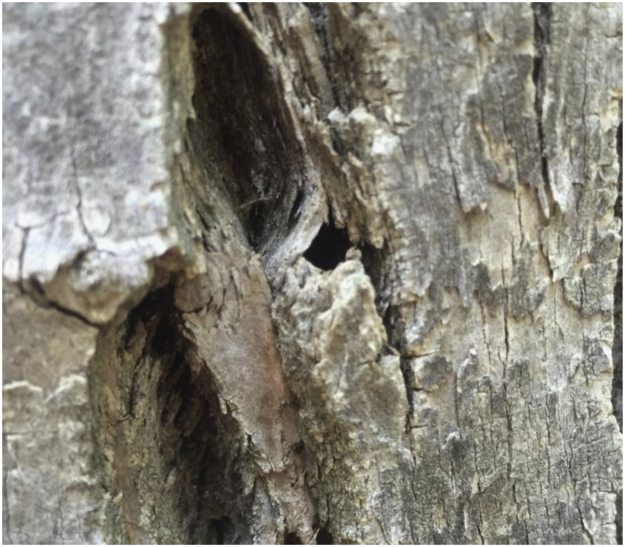
Borer hole found on Green Ash identified as a native borer species by UNL entomologist.